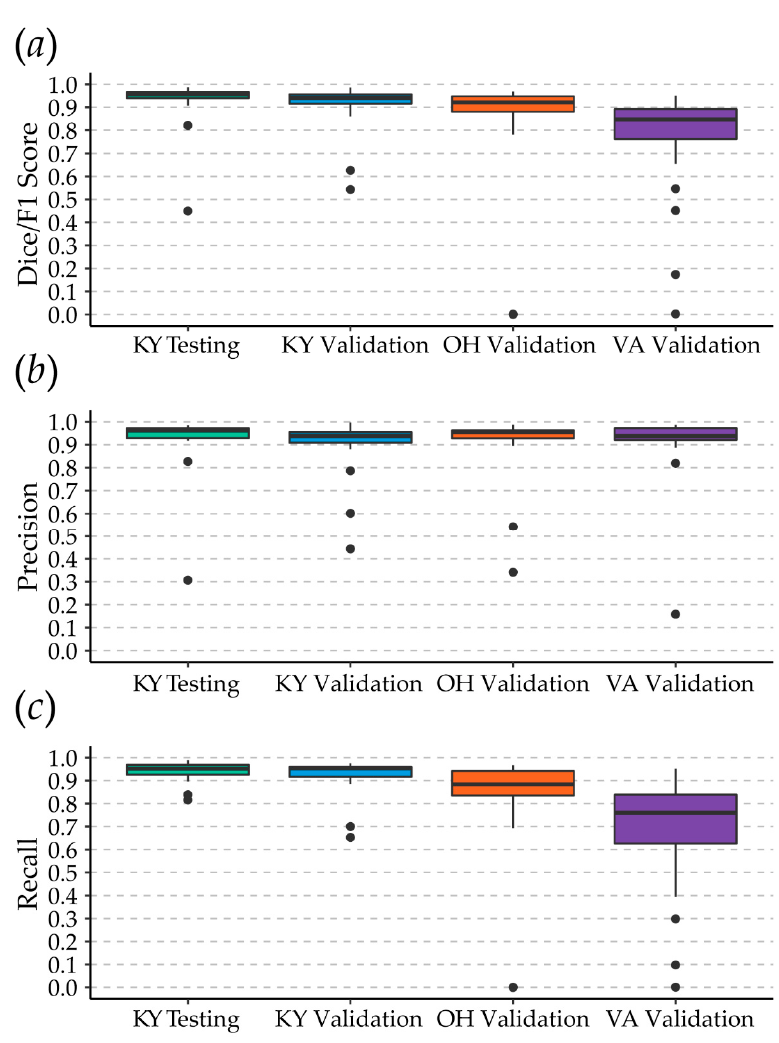
Figure 9. Boxplots showing the distribution of assessment metrics for entire quadrangles for different datasets. ( a ) Dice coefficient or F1 score, ( b ) precision, and ( c ) recall.